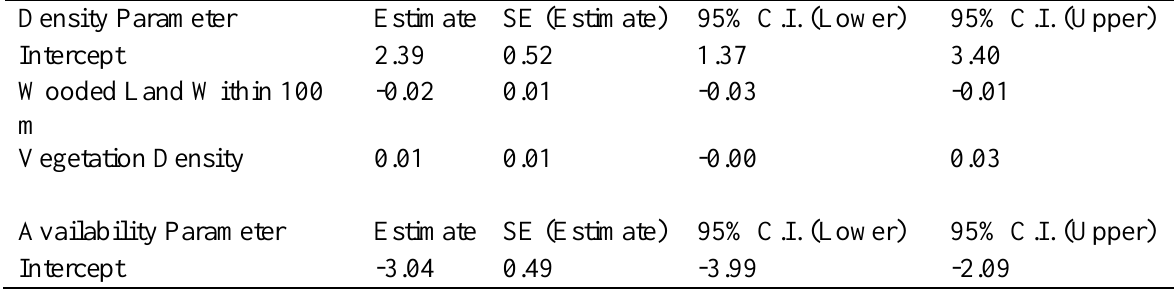
Table A2.C . Third-highest-ranking hierarchical distance-sampling model (AIC ∆ AIC =2.31, AIC weight=0.11) for Clay-coloured Sparrows along 34 transmission line study c sites in Winnipeg, Manitoba, Canada in 2007 (n=102 surveys), assuming a uniform detection probability with increasing distance of birds from the transect line and no effects of Julian date, time of morning, or observer experience on availability for